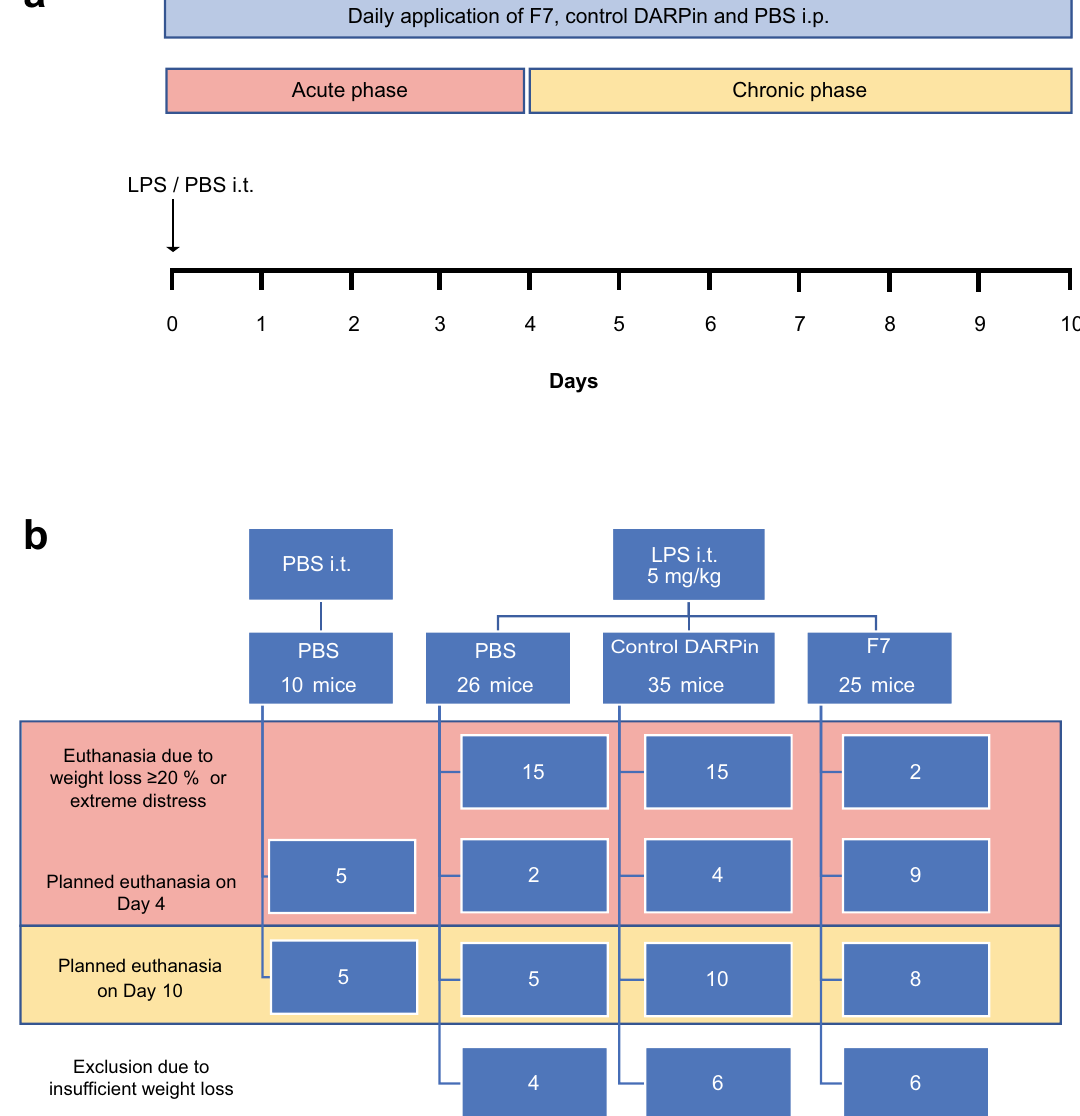
Figure 1. Conceptual figure describing the mouse model of LPS-induced acute lung injury and treatments. ( a ) Mice received 200 µg of F7, control DARPin and PBS daily via the intraperitoneal (i.p.) route beginning on day 0. On day 0 mice received intratracheal (i.t.) LPS (for F7, control DARPin and PBS group) or intratracheal PBS (for healthy controls). Day 1 to day 4 was considered the acute phase. Day 4–10 was considered the chronic phase of acute lung injury. ( b ) Overview of the number of mice in the different treatment groups and the time point of euthanasia. The number of mice per treatment group was determined according to the expected survival rate and the number of mice needed to show significant differences. Mice were pre-assigned to the acute or chronic phase. Planned euthanasia was conducted on day 4 (acute phase) or day 10 (chronic phase). Mice were euthanized early if they showed signs of severe weight loss or distress (Table 1) and were then counted as non-survivors. Several mice in the PBS and control DARPin group which were pre-assigned to the chronic phase had to be sacrificed early as they reached criteria for